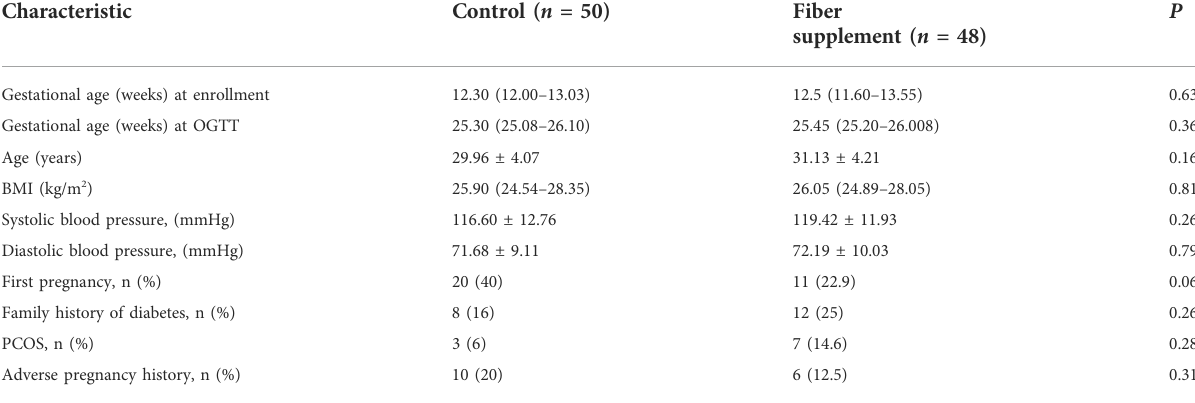
TABLE 1 Maternal demographic and medical characteristic in fi ber supplement and control